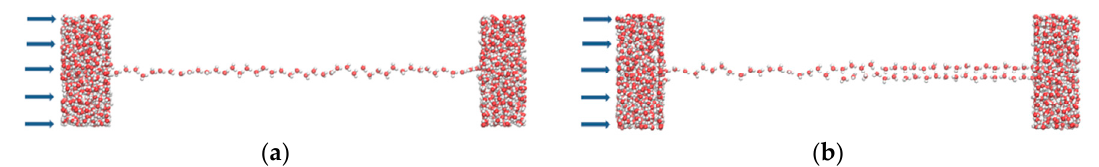
Figure 3. Visualization of water chain formed in-between two reservoirs: ( a ) perfect BNNT ( b ) BNNT with XY-distortion value 2.